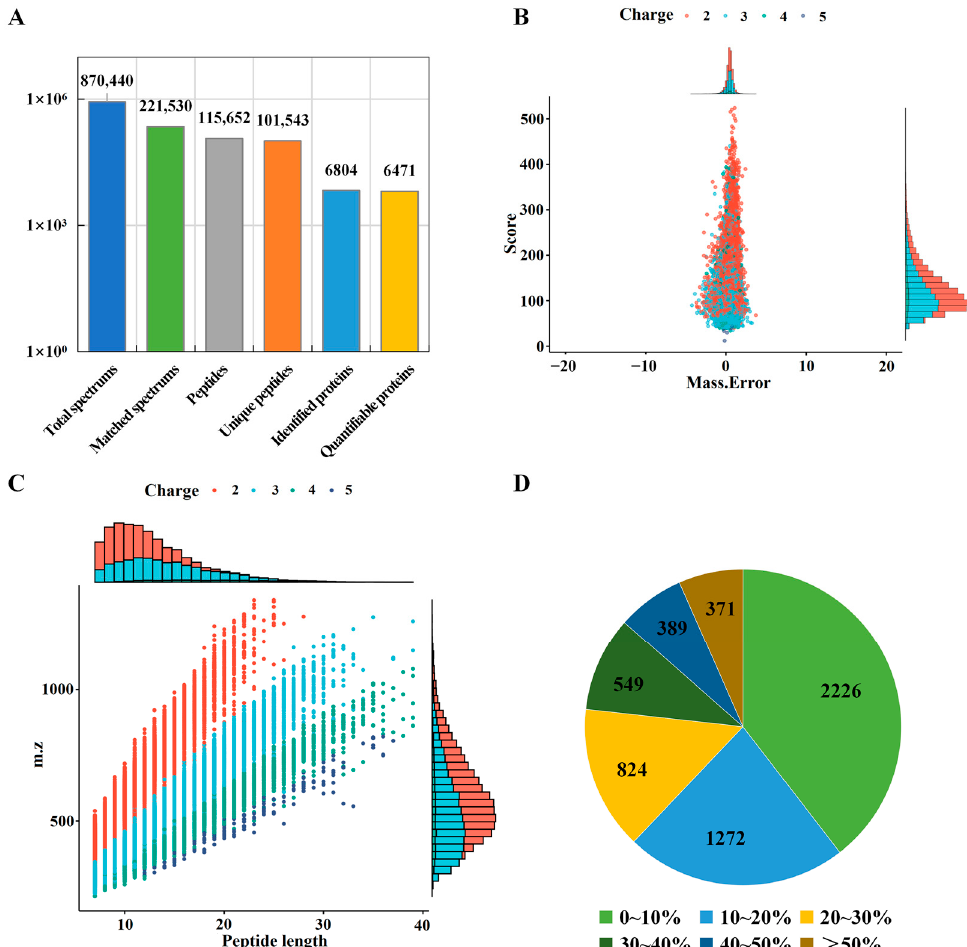
Figure 1. Characterization of identified proteins in Tibetan pig liver. ( A ) Statistical information of tandem mass spectra and protein identification; ( B ) number of identified peptides with mass error; ( C ) peptide length distribution; ( D ) protein coverage distribution map.